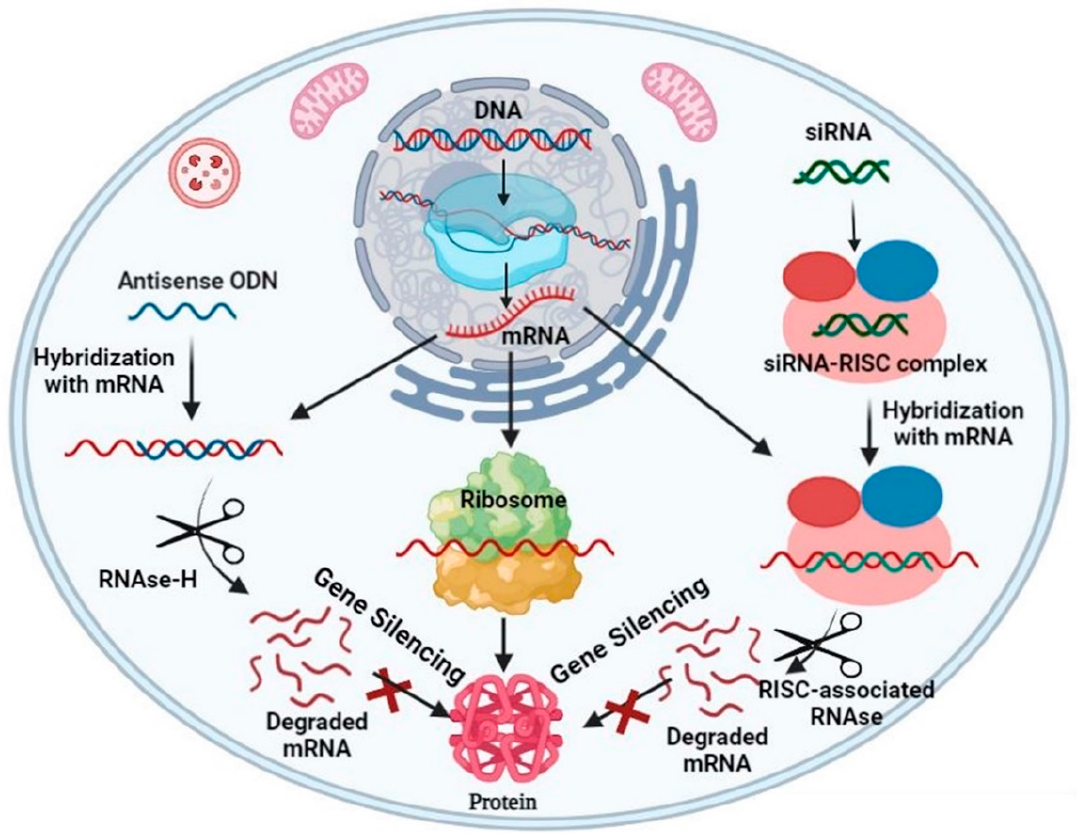
Figure 2. Schematic illustration of different cellular pathways involved in gene silencing. Reprinted with permission from Ref. [21]. Copyright 2022, Elsevier.